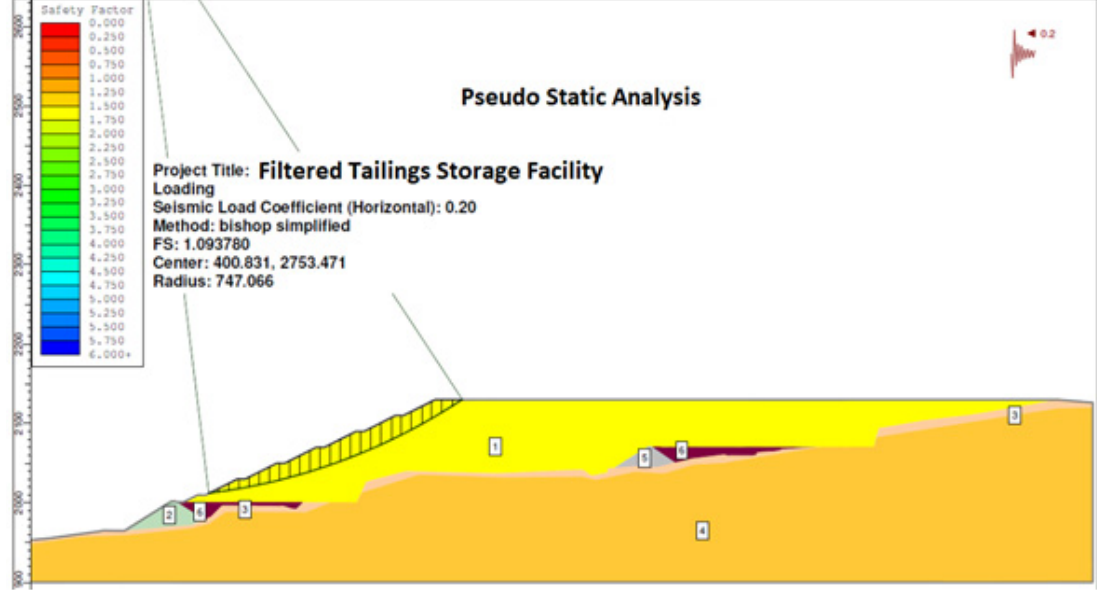
Figure 16. Typical Dry Stack TSF Stability Analysis.